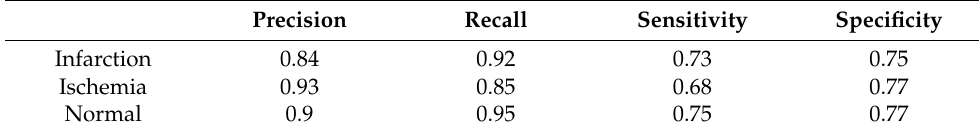
Table 11. Presentation of metrics of DenseNet-121 for each class, after a 10-fold procedure. Precision Recall Sensitivity Specificity Infarction 0.81